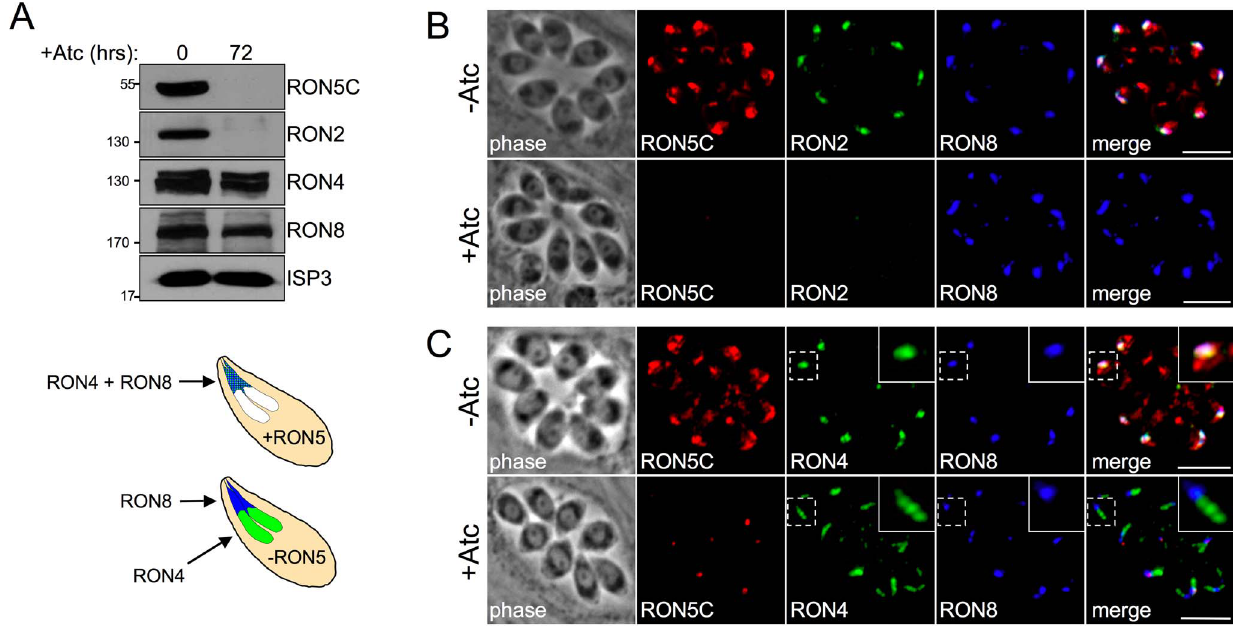
Figure 4. The MJ RON core complex is disrupted in the absence of RON5. (A) Western blot analysis of MJ RONs 2, 4 and 8 following RON5 knockdown. RONs 2, 4 and 8 were compared in the RON5 MYC cKD strain with or without 72 hours of Atc treatment. RON2 levels are similarly reduced following knockdown of RON5. In contrast, only a minor decrease in RON4 and RON8 levels is observed. ISP3 serves as a loading control. (B) IFA showing RON2 is lost in RON5 HA cKD parasites depleted of RON5 while RON8 levels and targeting are unaffected. Although a minor decrease in RON8 signal was observed by Western blot following depletion of RON5 (A), no change in RON8 was observed between vacuoles with or lacking RON5. Red: rat anti-HA antibody detected by Alexa594-anti-rat IgG. Green: rabbit anti-RON2 antibody detected by Alexa488-anti-rabbit IgG. Blue: mouse anti- RON8 antibody detected by Alexa350-anti-mouse IgG. (C) IFA showing RON4 is mistargeted to the rhoptry body in RON5 HA cKD parasites the absence of RON5. RON4 normally co-localizes with RON5 and RON8 in the rhoptry neck. However, in parasites depleted of RON5, co-localization between RON4 and RON8 is lost with RON4 signal extended just posterior to RON8 indicating mistargeting to the rhoptry body. Red: rabbit anti-HA antibody detected by Alexa594-anti-rabbit IgG. Green: rat anti-RON4 antibody detected by Alexa488-anti-rat IgG. Blue: mouse anti-RON8 antibody detected by Alexa350-anti-mouse IgG. All scale bars=5 m m.